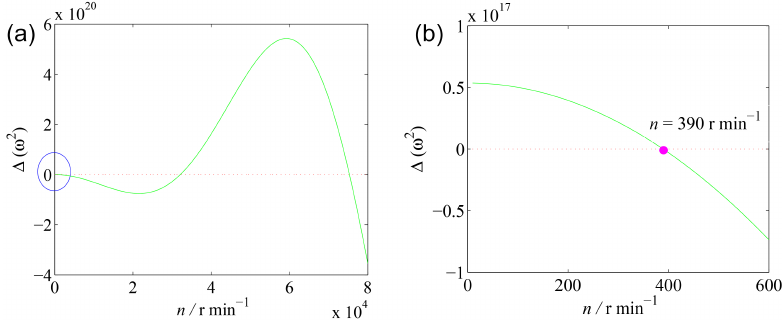
Figure 15. Residual volume (cid:49) ( ω 2 ) curve. (a) Residual volume curve n - (cid:49) ( ω 2 ). (b) Local enlarged drawing of (a)